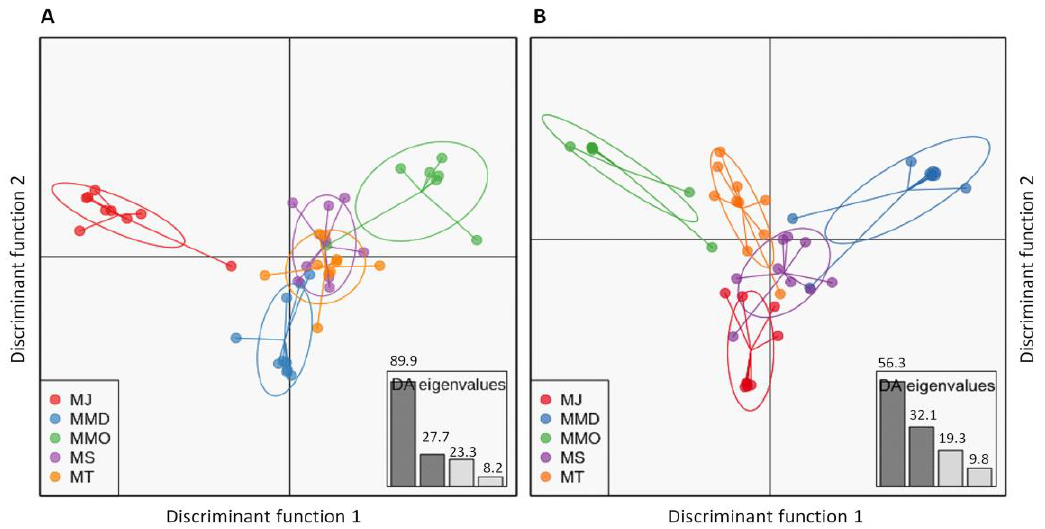
Figure 3. Plots showing the discriminant analysis of principal components (DAPCs) of genetic differentiation for the all ( A ) and the putatively adaptive ( B ) SNP loci of five broodstock populations of Penaeus monodon . Ovals are the inertial ellipse, dot represent individual genotypes and the line extends to centroids of each population Here, MJ indicate samples from Shizuoka, Japan (wild); MMD indicates samples from Mahajamba, Madagascar (Domesticated); MMO indicates samples from Hawaii, HI, USA (Domesticated); MS indicate samples from Setiu Wetland, Malaysia (wild); MT indicates samples from Petchaburi, Thailand (Domesticated).